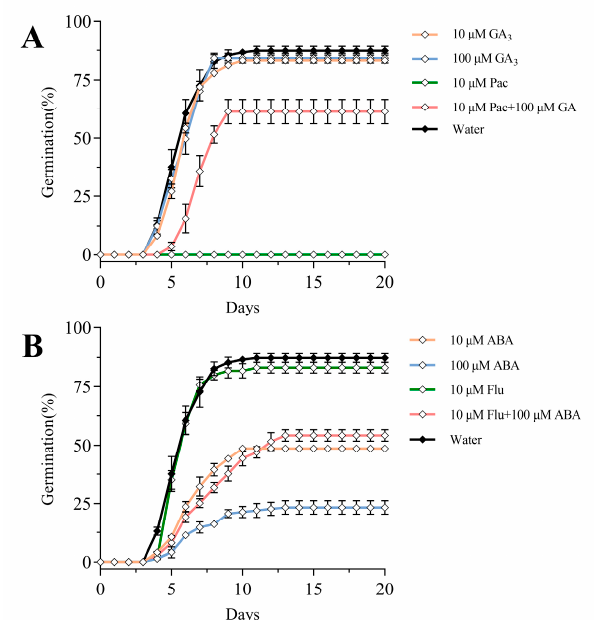
Figure 4. Effects of gibberellin, abscisic acid, and their biosynthesis inhibitors on seed germination. ( A ) Effects of exogenous gibberellin and its synthesis inhibitors on seed germination. ( B ) Effects of abscisic acid and its inhibitors on seed germination. The germination environment of seed was 100 μ mol m − 2 s − 1 , 24 h photoperiod, constant temperature at 24 °C. Both gibberellin and abscisic acid were dissolved by 0.1% DMSO. Vertical bars indicate means ± SD ( n = 3).